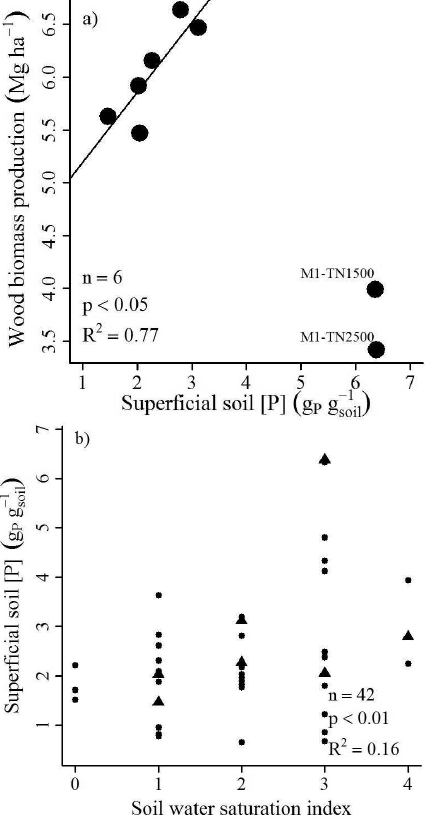
Fig. 6. (a) Significant relationship between available phosphorus at the soil surface and total aboveground wood productivity (AGWBP) excluding M01 plots, and (b) significant relationship between re- gionally available phosphorus at the soil surface and soil water sat- uration index, with triangles representing the eight sampled sites of this